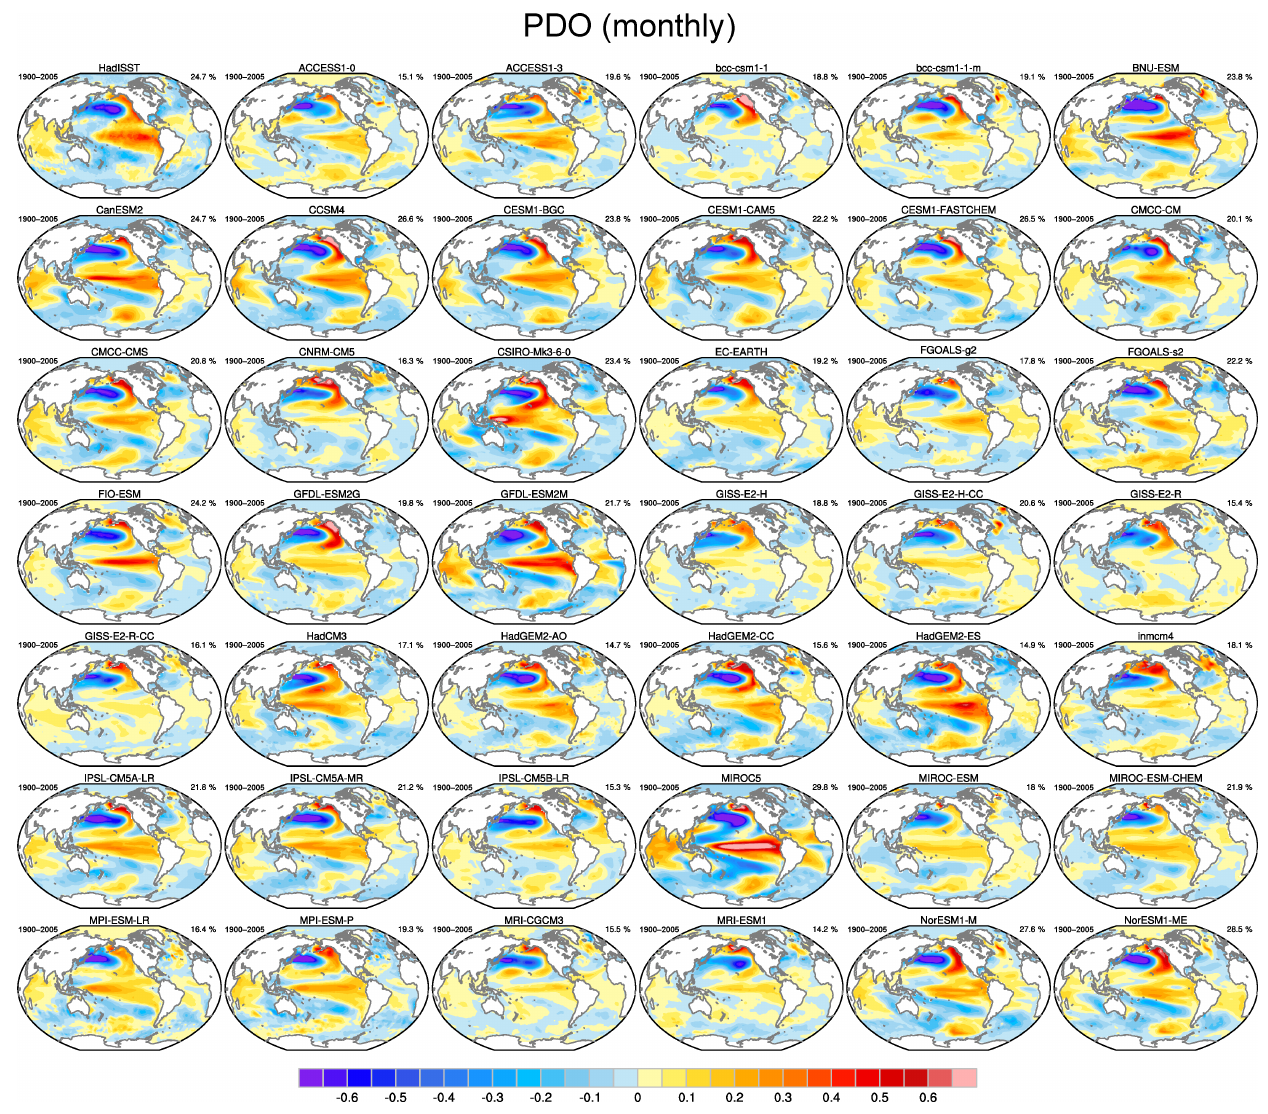
Figure 8. The PDO as simulated by 41 CMIP5 models (individual panels labelled by model name) and observations (upper left panel) for the historical period 1900–2005. These patterns show the global SST anomalies ( ◦ C) associated with a one standard deviation change in the normalized principal component (PC) time series. The percent variance accounted by the PDO is given in the upper right of each panel. The PDO is defined as the leading empirical orthogonal function of monthly SST anomalies (minus the global mean SST) over the North Pacific (20–70 ◦ N, 110 ◦ E–100 ◦ W). The global patterns ( ◦ C) are formed by regressing monthly SST anomalies at each grid point onto the PC time series. Most CMIP5 models show realistic patterns in the North Pacific. However, linkages with the tropics and the tropical Pacific in particular, vary across models. The lack of a strong tropical expression of the PDO is a major shortcoming in many CMIP5 models (Flato et al., 2013). Figure produced with namelist_CVDP.xml